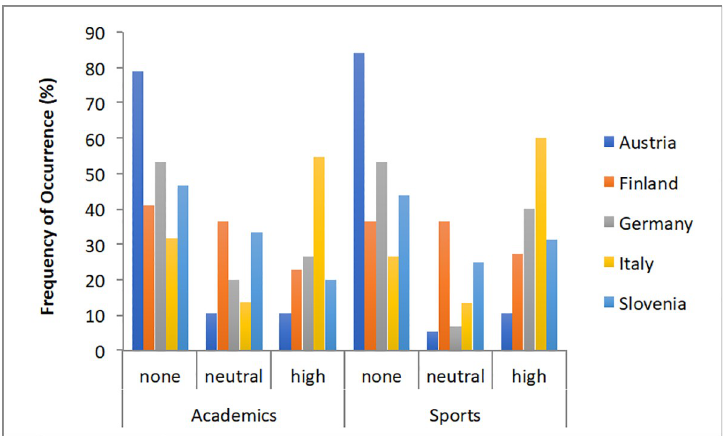
Fig 13. Frequency of occurrence (%) of decreased performances in relation to the country of the student-athletes.